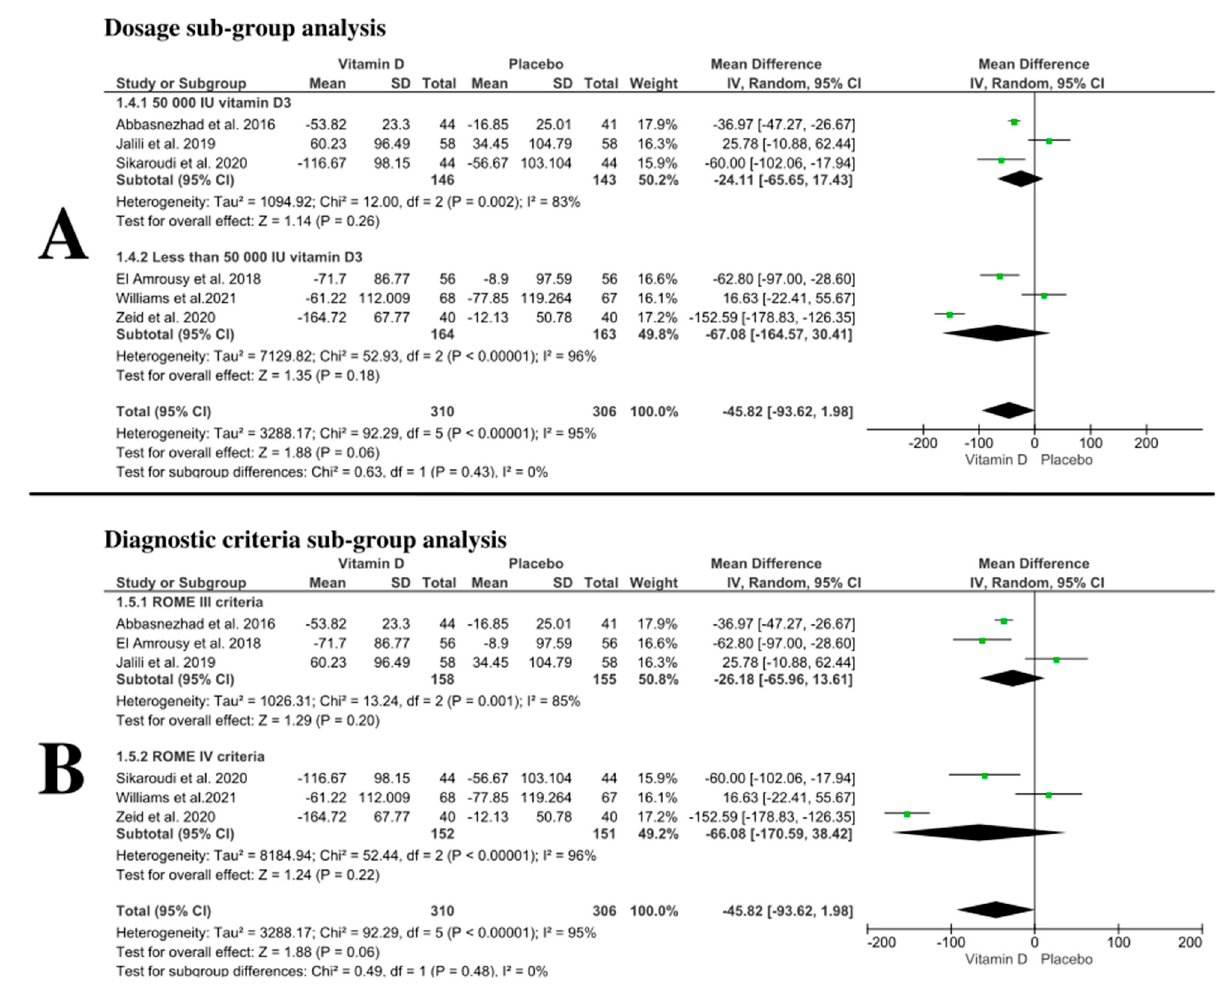
Figure 4. Forest plot of the sub-group analysis (( A )—dosage sub-group analysis, ( B )—diagnostic criteria sub-group analysis) I2: I-squared; CI: confidence interval [27–32,43].